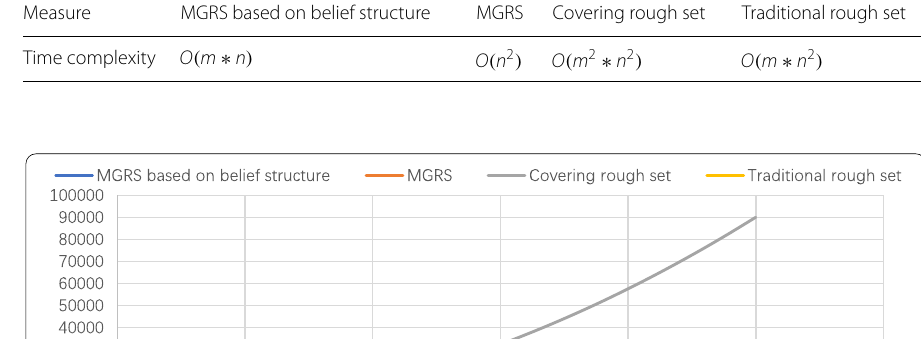
Table 5 The comparison of time complexity of different rough set measures Measure